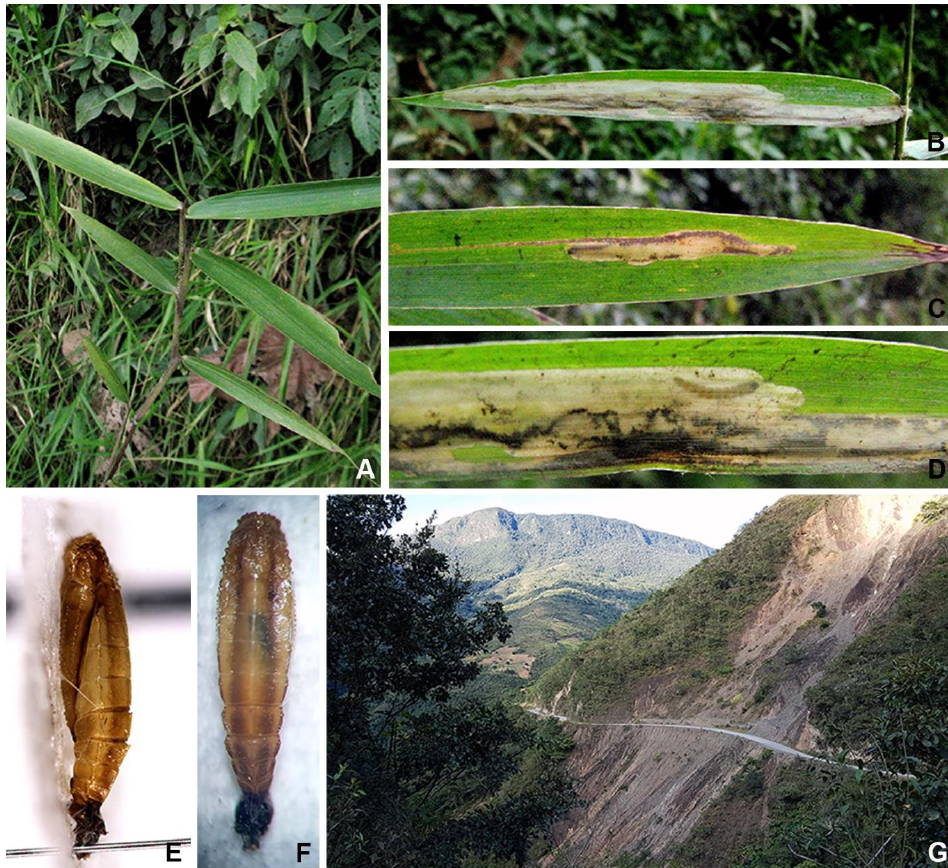
Figure 4. Immature stages and habitat of Elachista stonisi sp. nov.: ( A ) host plant, Poaceae sp.; ( B – D ) leaf-mines; ( E , F ) pupa; ( G ) habitat where the leaf mines were found, Yungas Province, Bolivia.